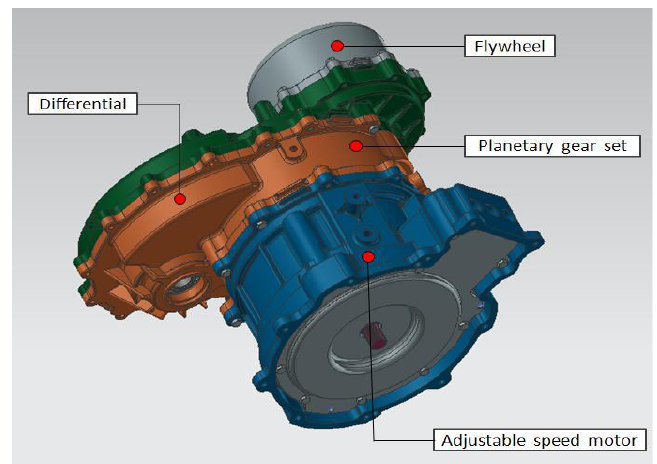
Figure 1. 3-D model of the i-KERD assembly.